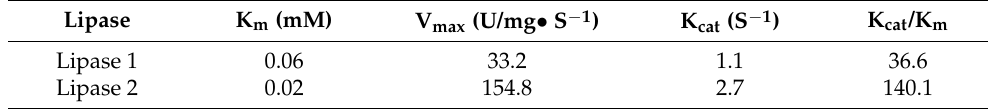
Table 3. Kinetics of p -NPP hydrolysis by Lipase 1 and Lipase 2.